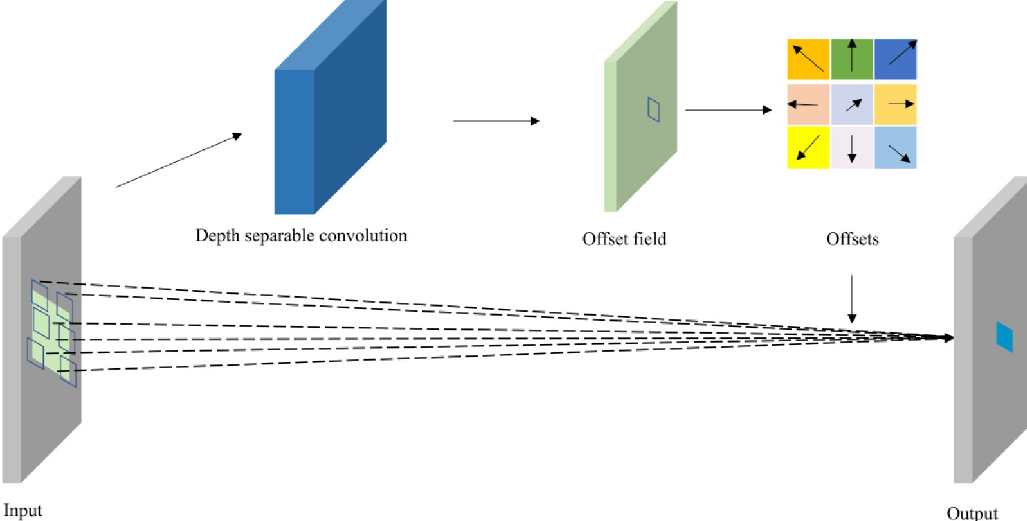
Fig 5. Schematic diagram of the depth separable deformable